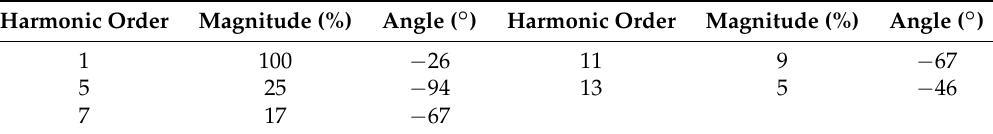
Table 1. Line Current Harmonic Content of the EV Charger